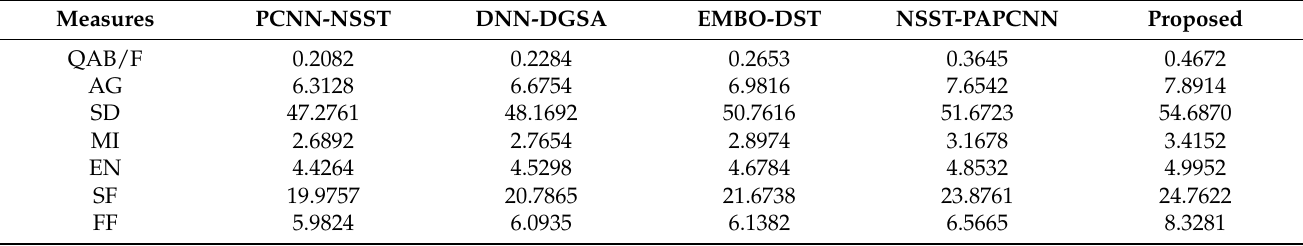
Figure 7. Fusion results of CT and SPECT images. Table 3. Objective computation of various methods on medical image fusion for CT and